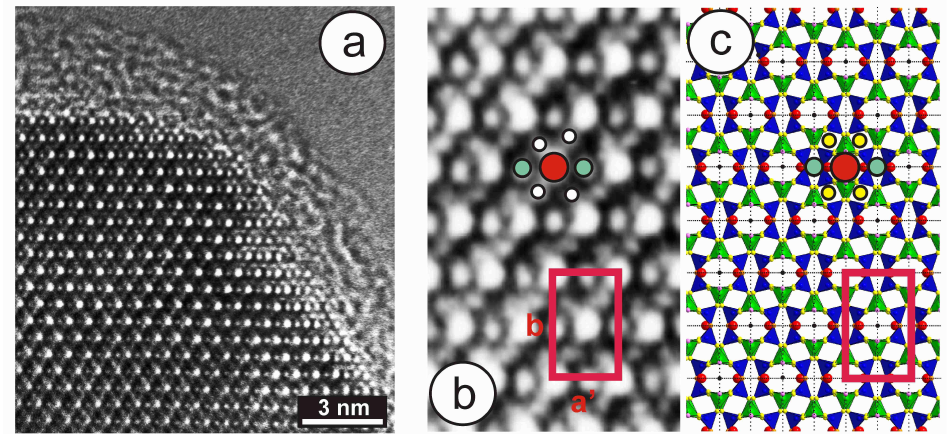
Figure 14. ( a ) High-resolution electron-microscopy image along the [001] zone axis in specimen 1123, with bright dots from different types of T rings. ( b ) High-resolution and high-magnification digital image from the upper right region of ( a ); three types of structural channels are marked with colors, as well as the a and b dimensions (see explanation in text), compared to the channels expected in the monoclinic lattice model in ( c ) by using XRD data from [72]. The K atoms are shown in red, T 1 sites in green, T 2 sites in dark blue, oxygen atoms in A1 site in pink, in A2 in orange, the rest in yellow. The electron-diffraction patterns and the electron-microscopy images were obtained with a JEOL 4000EX instrument at 400 kV, as explained in detail in